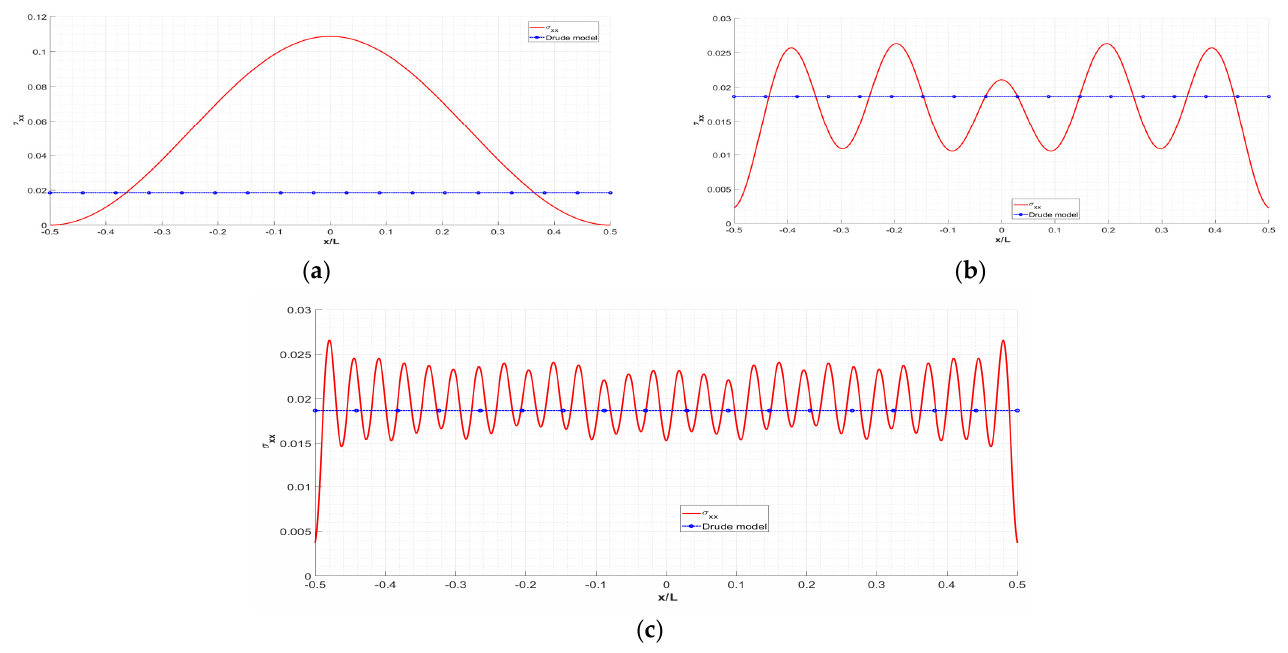
G Ll for different values of Drude